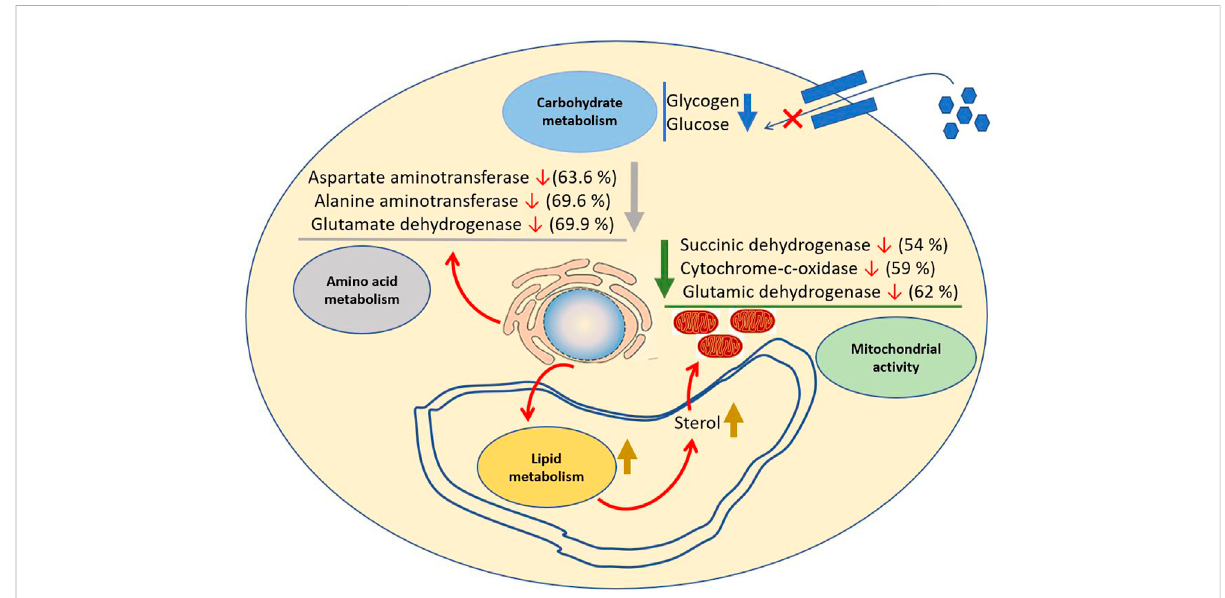
FIGURE 7 Environmental induced alteration of metabolism of P. globosa . Sterol plays a major role in metabolism during the dormant period. The sterol concentration suddenly rises during the dormant period which decreases the activity of respiratory and mitochondrial enzymes such as succinate dehydrogenase, cytochrome-c-oxidase, and glutamic dehydrogenase. Similarly, sterol also decreases amino acid as well as carbohydrate metabolism.